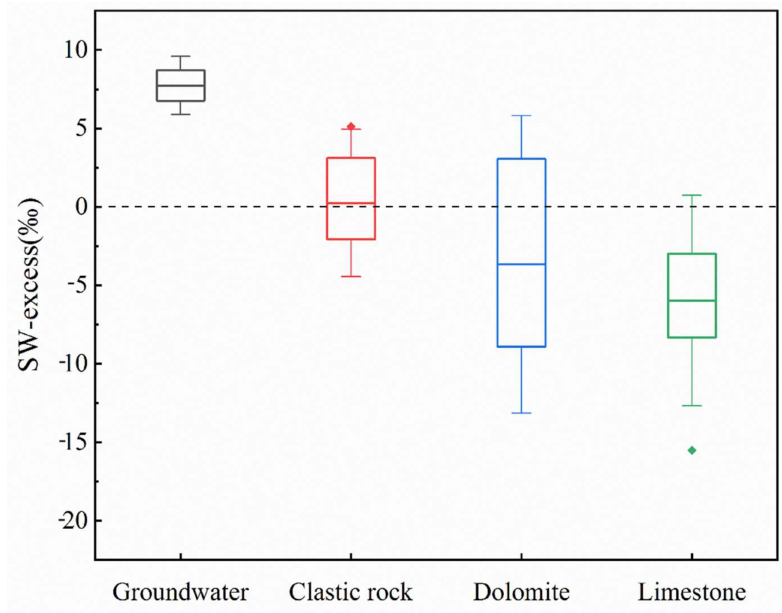
Figure 8. Variation characteristics of SW-excess of plants in the study